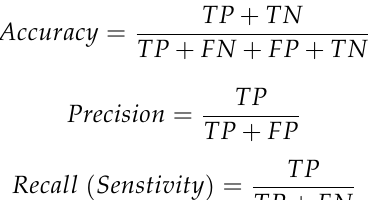
Table 3. Prediction results according to different windowing intervals and different feature sets.